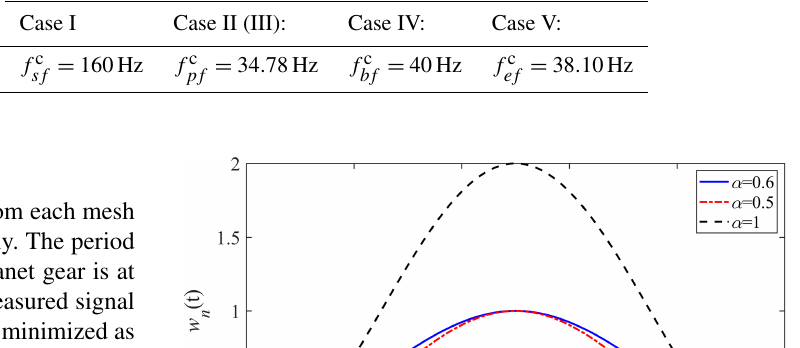
Table 3. Each characteristic frequency for a given operating condition. Meshing